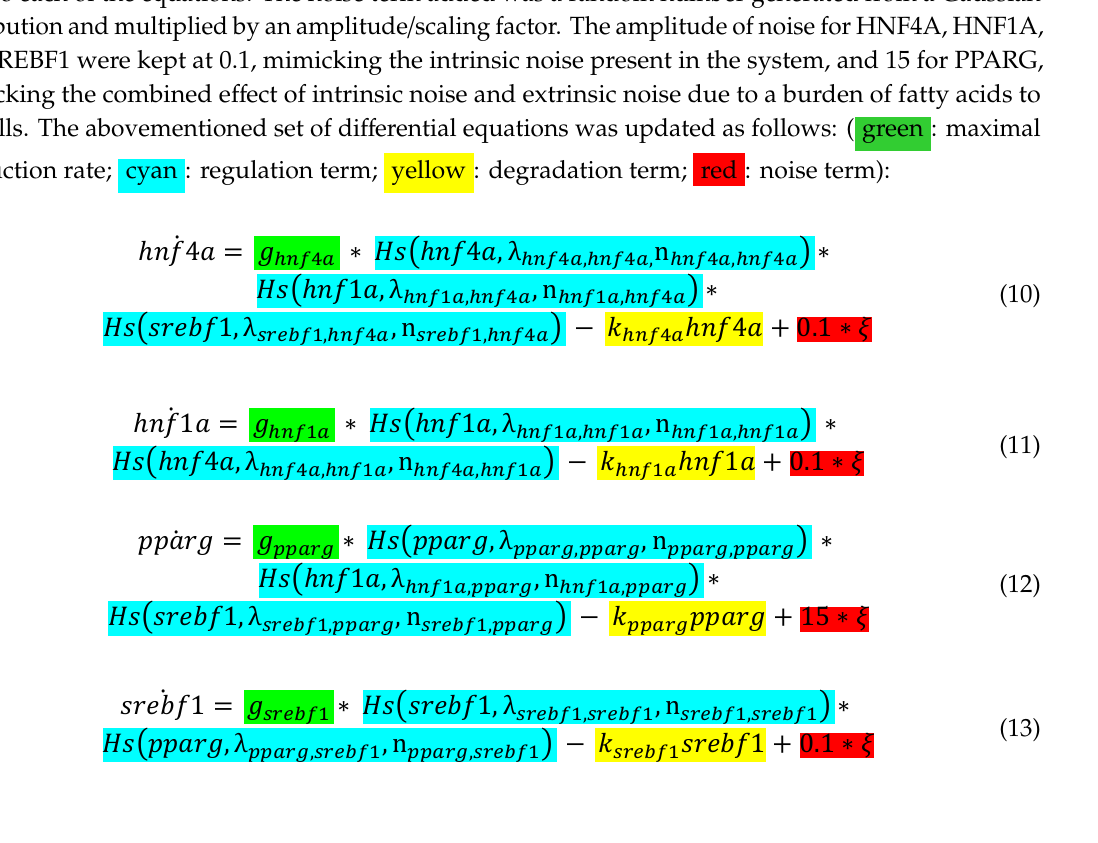
Table 2. Activation or inhibition parameters for the interaction.